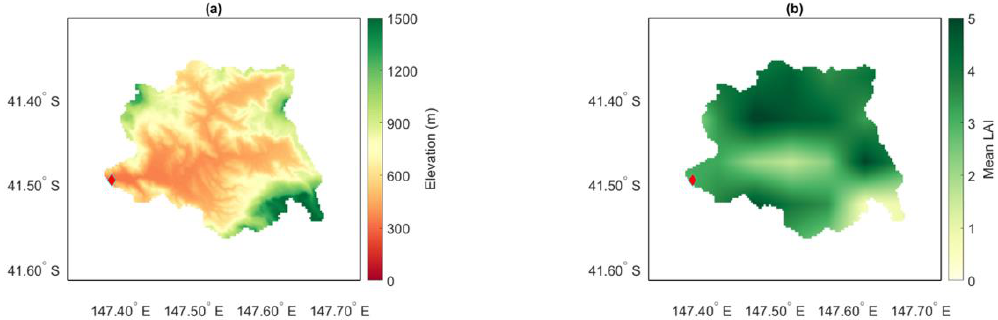
Figure 6. Spatial distributions of ( a ) elevation and ( b ) mean LAI during the 5-year validation period (2010–2014) over 318076 catchment. Here, the red diamond mark in the east indicates the catchment outlet.